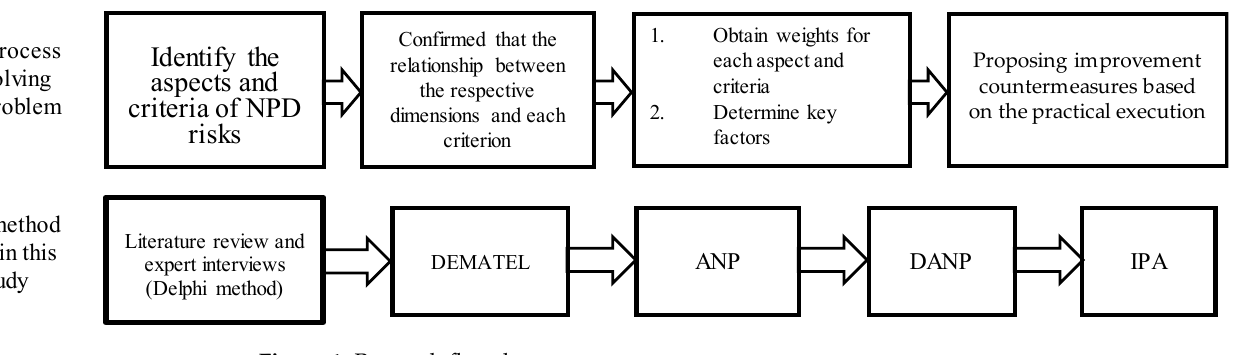
Figure 1. Research Figure 1. Research flowchart.